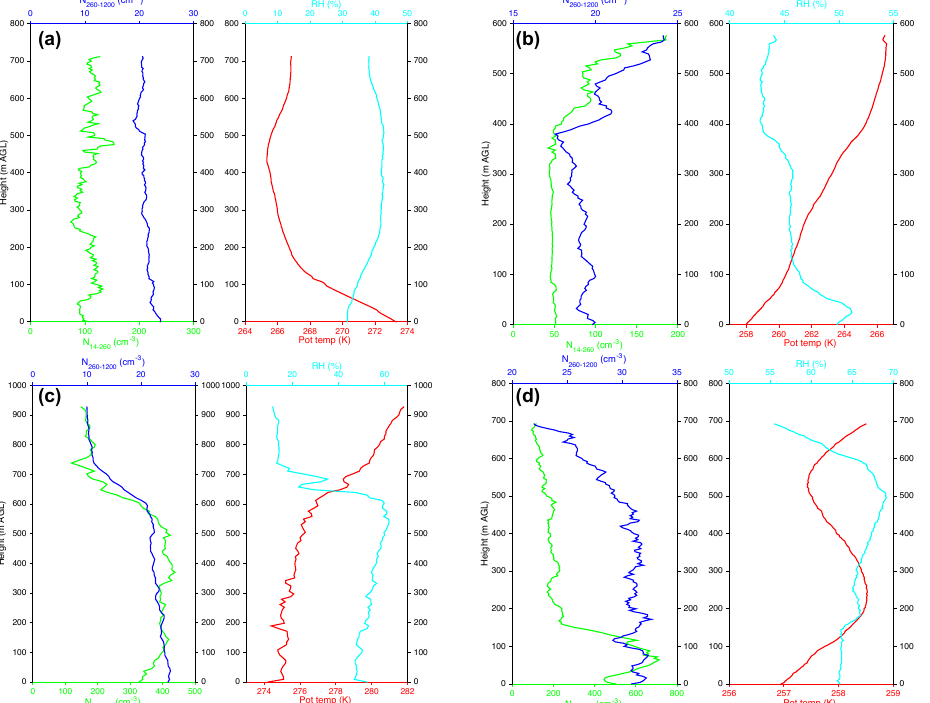
Figure 2. Vertical profiles of N 14 − 260 (green line), N 260 − 1200 (blue line), potential temperature (red line) and relative humidity (light blue line) measured over Ny-Ålesund on (a) 7 April 2011 (12:51–13:10UTC); (b) 1 April 2011 (06:30–06:57UTC); (c) 23 April